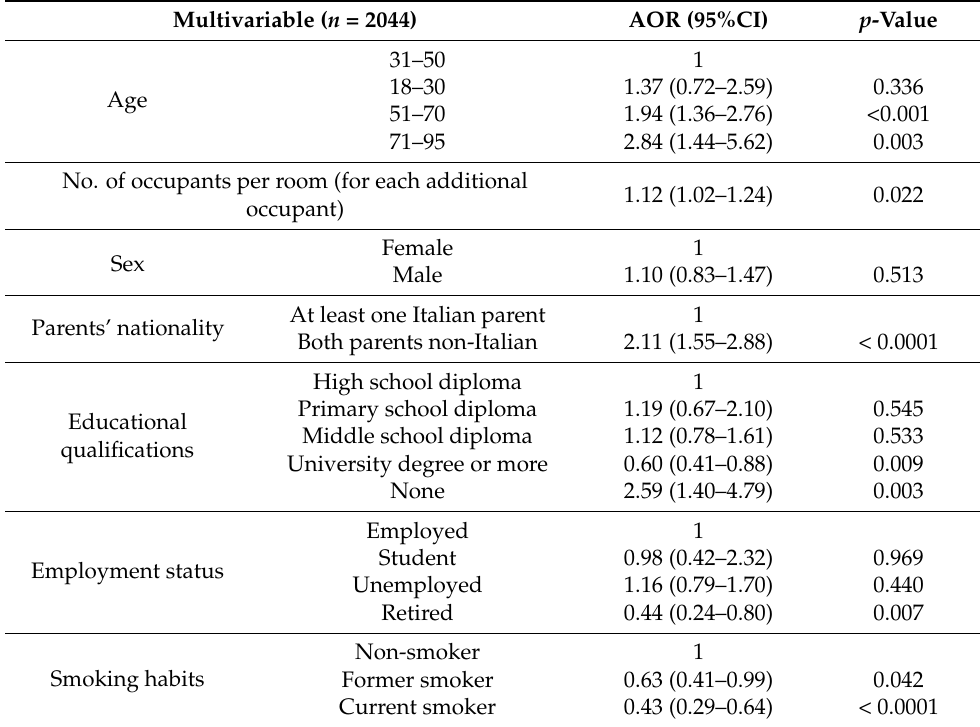
Table 2. Correlations between selected variables and prevalence of SARS-CoV-2 infection.